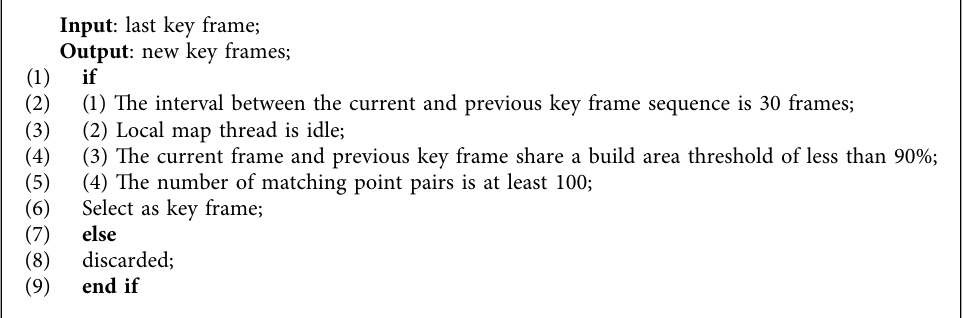
A LGORITHM 2: Key frame selection algorithm.